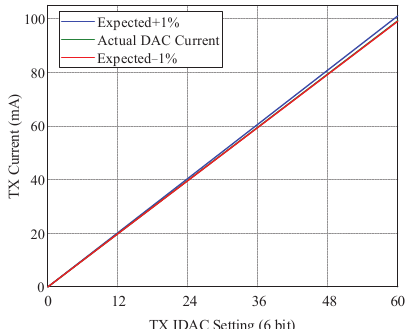
Figure 13. TX current linearity in the 100 mA range.